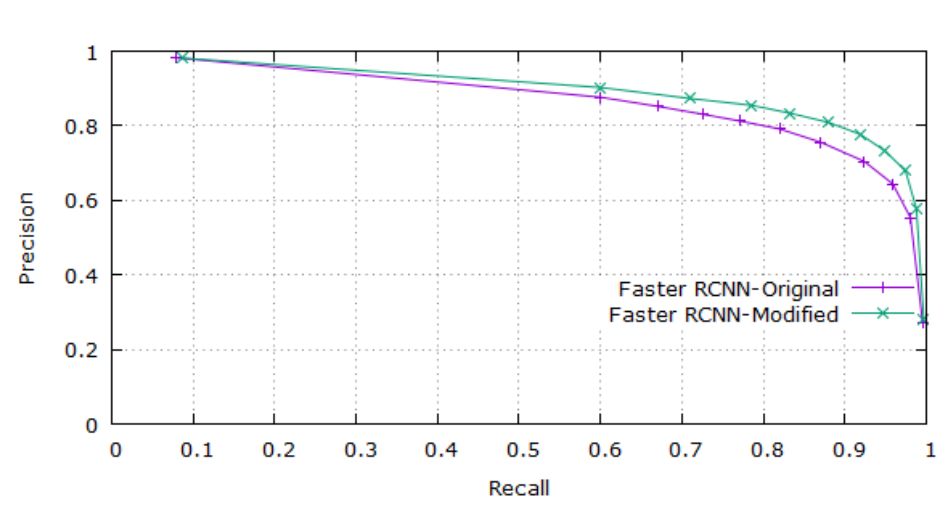
Figure 7. Performance comparison between original faster R-CNN ResNet50 model and its modified version on validation